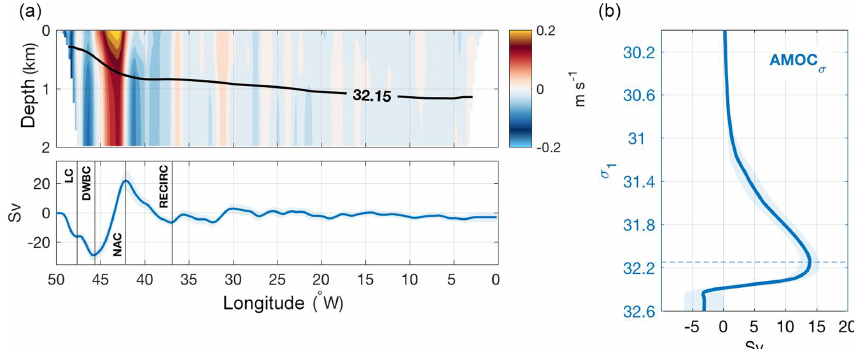
Figure 2. Meridional velocity and transport at 45 ◦ N (AMOC σ ). (a) Top panel: the 1993–2017 mean longitude–depth velocity field (in ms − 1 ) at 45 ◦ N. The σ 1 = 32 . 15 isopycnal across which the maximum diapycnal flux occurs is shown in black. Bottom panel: the depth-integrated (0–2000m) zonally cumulated transport (in Sv) at 45 ◦ N with labels as follows. LC (Labrador Current), DWBC (Deep Western Boundary Current), NAC (North Atlantic Current), and RECIRC (NAC recirculation). Shading indicates the ensemble standard error. (b) The mean AMOC σ stream function at 45 ◦ N (in Sv). Shading indicates the ensemble standard error. The dashed blue line at σ 1 = 32 . 15 depicts the maximum transformation rate.